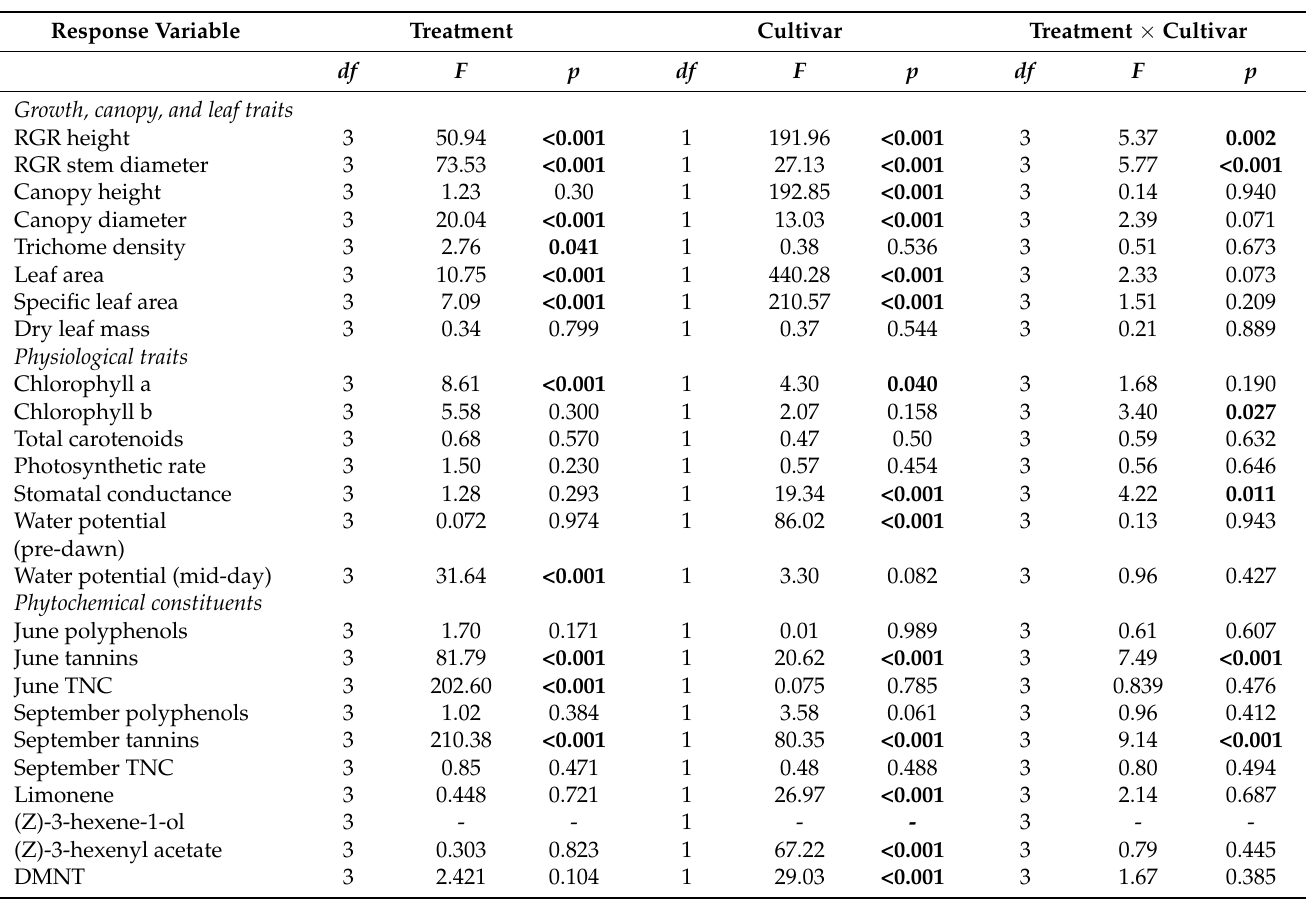
Table 2. ANOVA results testing the effect of treatment (control, defoliated, herbicided, and girdled) on responses of two red maple ( Acer rubrum ) cultivars (‘Brandywine’ and Franksred’). Significant values are in bold